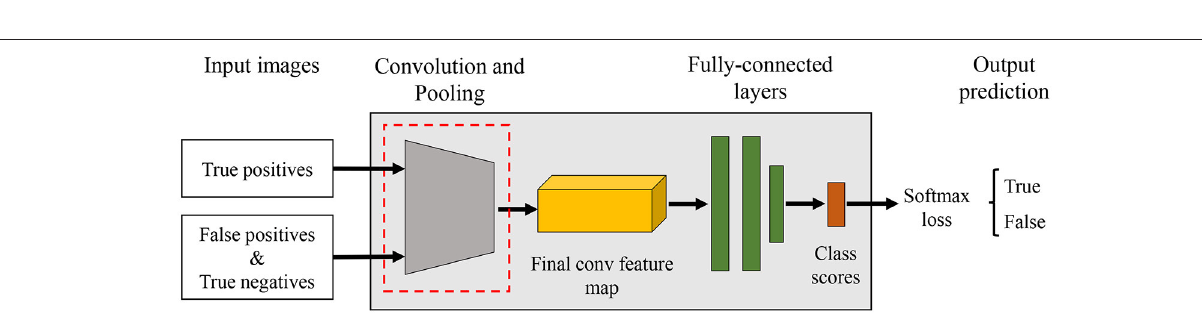
FIGURE 9 | Areas containing suspicious infections due to diseases and pests that are generated by the primary diagnosis unit and used as input to the CNN Filter Banks. (A) Canker, (B) Gray mold, (C) Leaf mold, (D) Low temperature, (E) Miner, (F) Nutritional excess, (G) Plague, (H) Powdery mildew, (I) Whitefly, (J) Background.